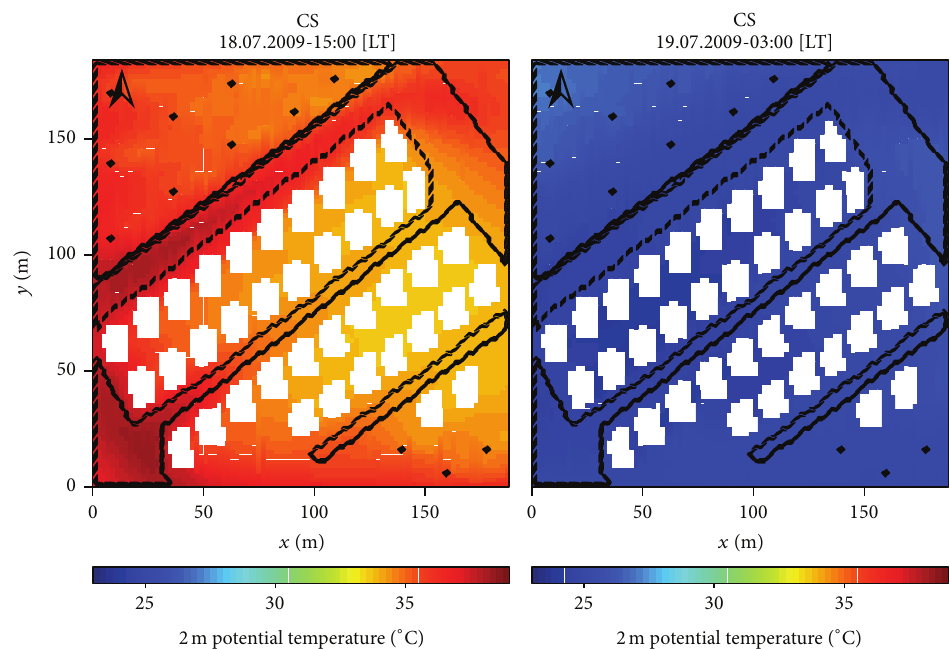
Figure 11: 2 m potential temperature distribution in the study area in current situation (CS) on a hot summer day (July 18th) at 15:00 and 03:00 h local